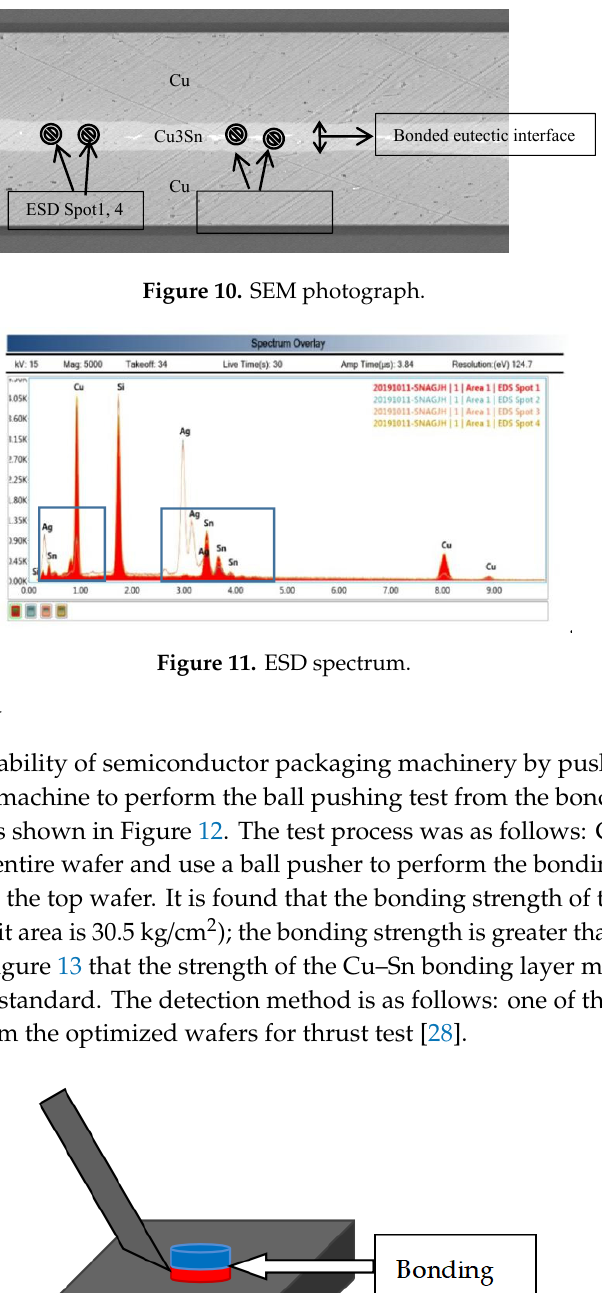
Figure 13. Result of the binding test after optimization of parameters. 3.3. Electrical Performance Test We conducted the circuit conduction test on the series bumps with daisy chain, added the DC signal to the pads at both ends of the daisy chain, used a multimeter to measure the series resistance and calculated the average value of the contact resistance as 3.35 m Ω [29]. There were 44,100 bumps in a single die. Among them, 3178 were distributed on the daisy chain. A total of 68 series routes were formed, all of which were conductive, and the conductivity was 100%. Among them, the bumps were activated on the daisy chain in each region. With the increase of the number of series bumps, the resistance value had a linear relationship with the number of bumps. Figure 14 was to select 5 dies in 5 regions of the wafer after bonding and calculate the resistance of each series line to obtain a graph of the number of bumps and the resistance value. Figure 15 was a schematic diagram of region selection on a wafer and a schematic diagram of serial circuits on a die. The distribution of the bumps in the four areas above a die was the same, according to the engineering drawing, the diagonal center is measured from the four corners. The contact resistance of each pair of bumps is shown in Figure 16. ( a )